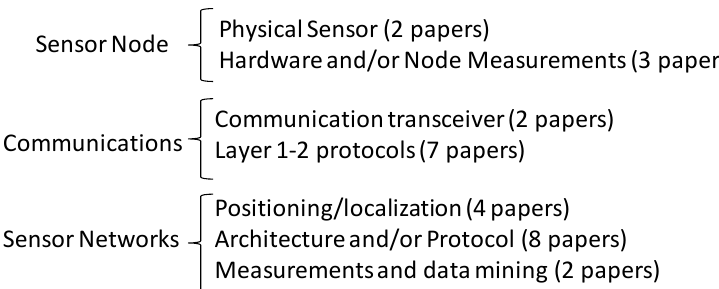
Figure 1. Special Issue Papers classification.